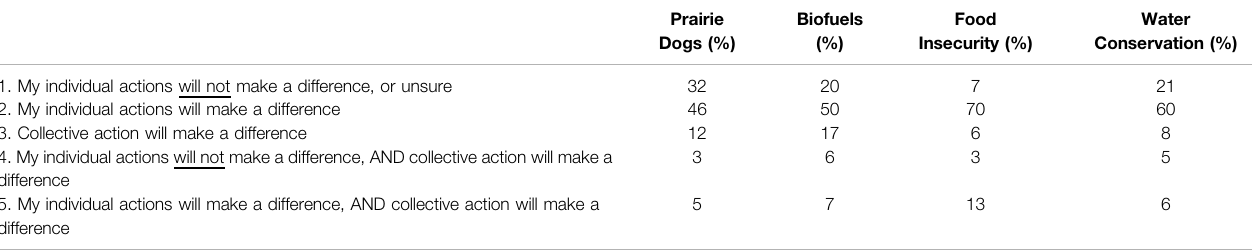
TABLE 3 | Student responses to “ Effectiveness ” prompt: “ Do you think your actions regarding this issue will make a difference? Why or why not? ” The % of students who respondedineachcodingcategoryforeachtopic.Eachcodecategoryismutuallyexclusivesuchthatnoonestudentresponsewascountedformorethanonecode( n (cid:1) 145), a small number of students were missing a response so not all columns add to